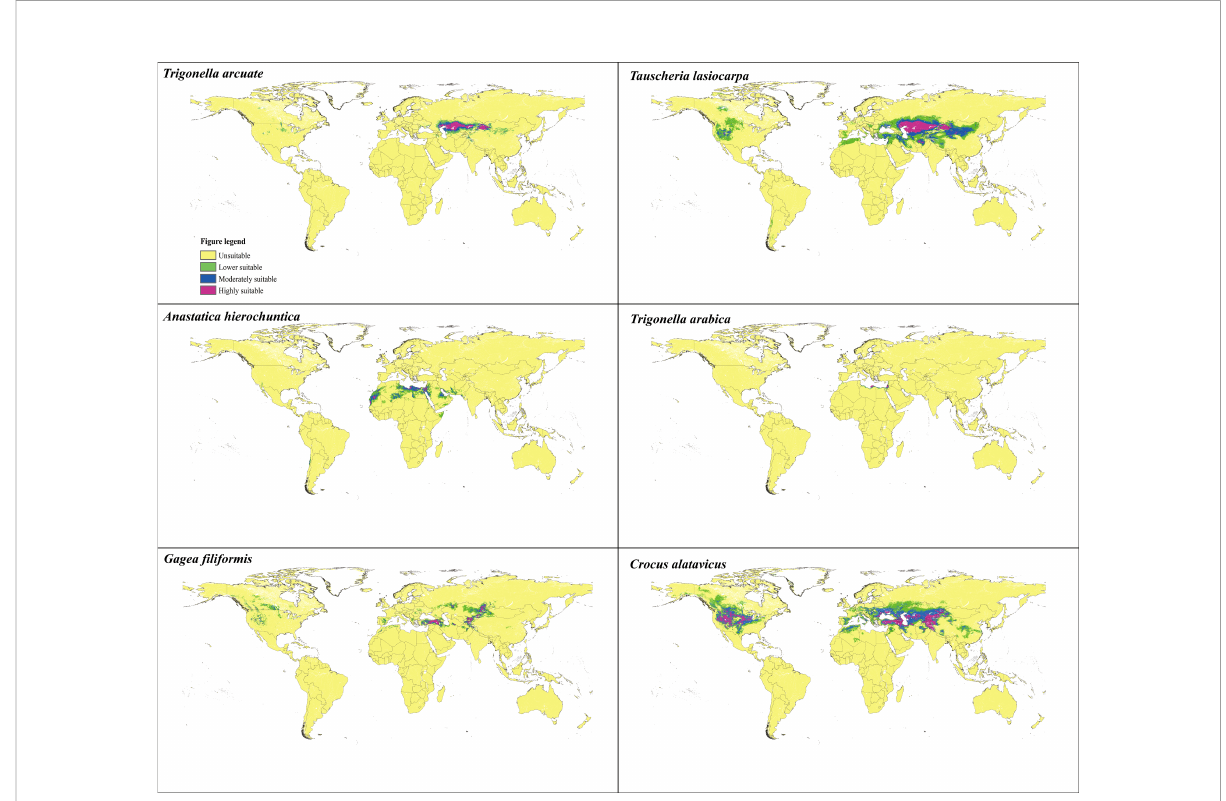
FIGURE 3 Potential suitable distribution habitat of six ephemeral plants under the current scenarios.